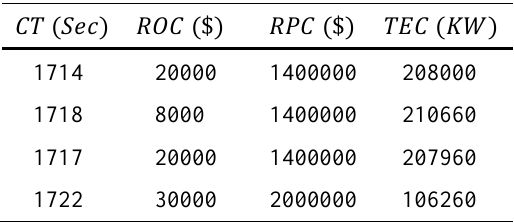
Table 2. Payoff table of the objectives.